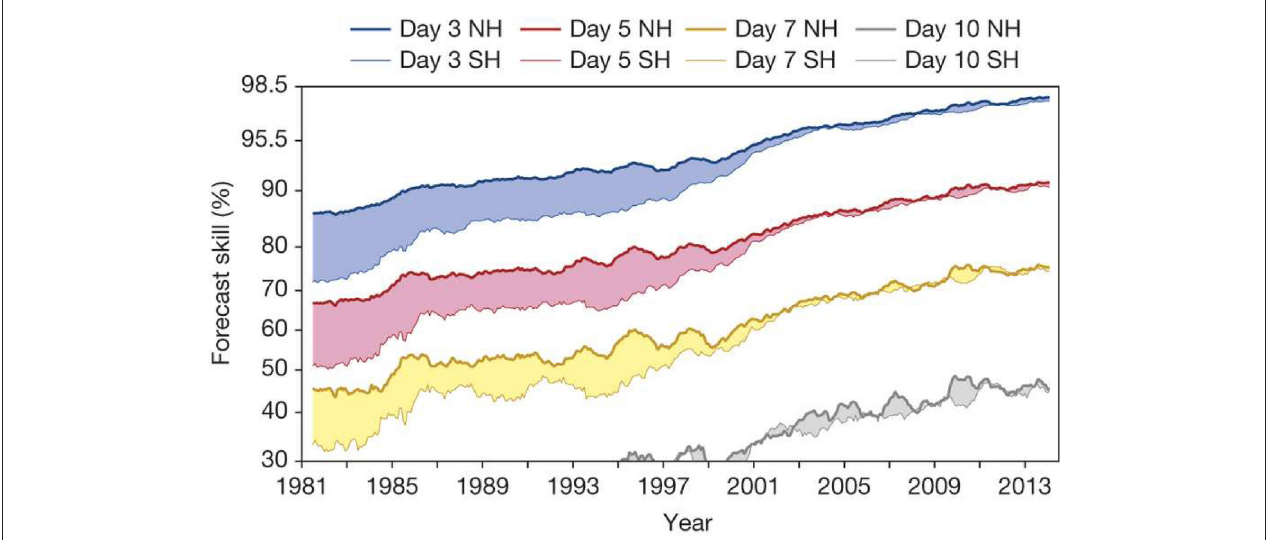
FIGURE 4 | Development of weather forecast skill since 1981 for 3, 5, 7, and 10 day lead times for the northern (NH) and southern hemispheres (SH). Forecasts are regarded as being useful if they exceed a skill of 60%, while > 80% is considered to be of high accuracy. Forecast skill is the correlation between the forecasts and the verifying analysis of the height of the 500-hPa level, expressed as the anomaly with respect to the climatological height. The collapse of the curves in the late 1990s is due to advances in incorporating satellite observations into forecast models. Reprinted by permission from Macmillan Publishers Ltd, Nature (Bauer et al., 2015) copyright